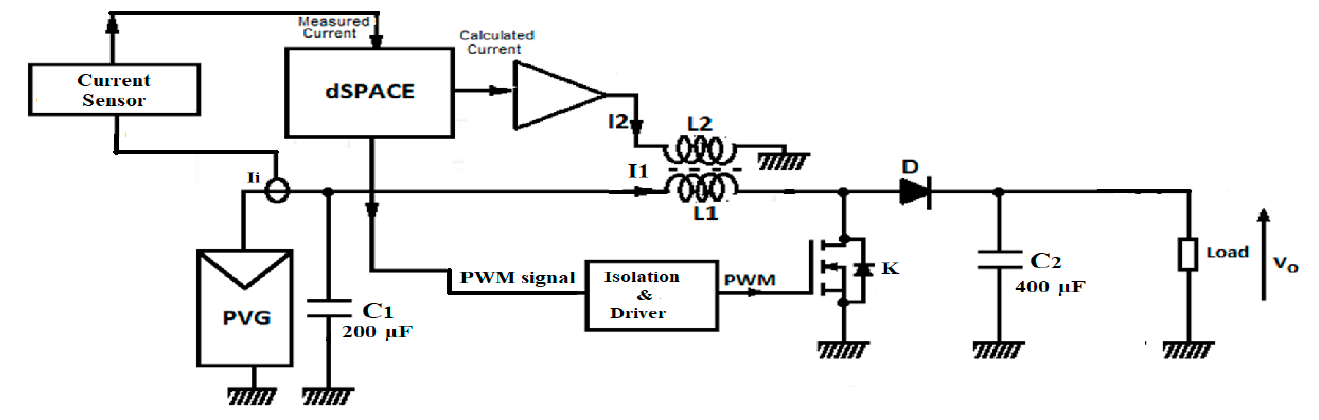
Figure 4. PV system using boost converter with a coupled inductor.